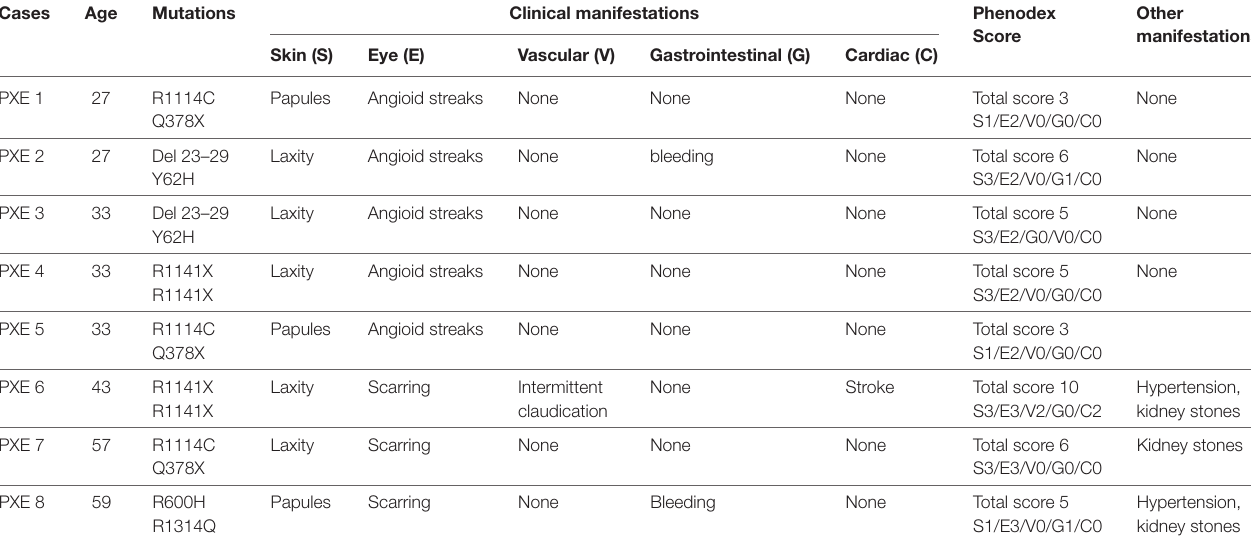
Table 2 | Clinical and molecular features in pseudoxanthoma elasticum (PXE)